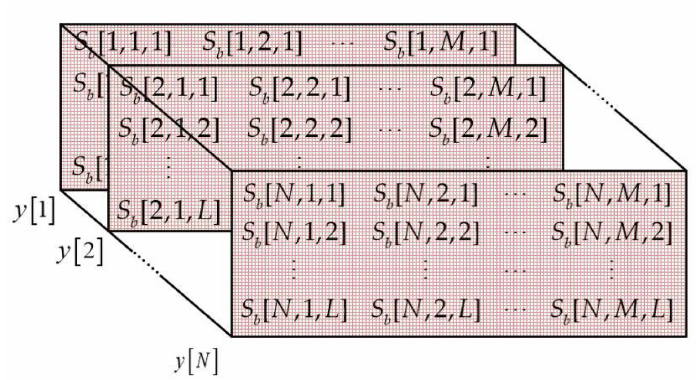
Figure 2. The received radar data cube.